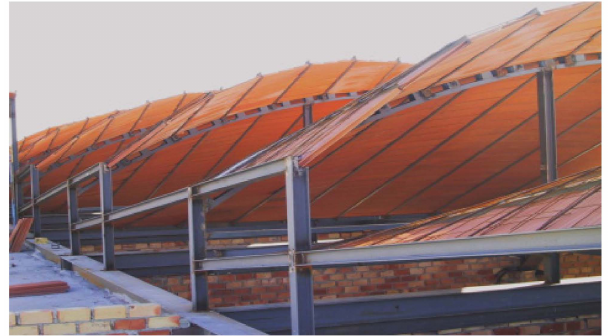
Figure 7. A view of the new ceramic vaults.